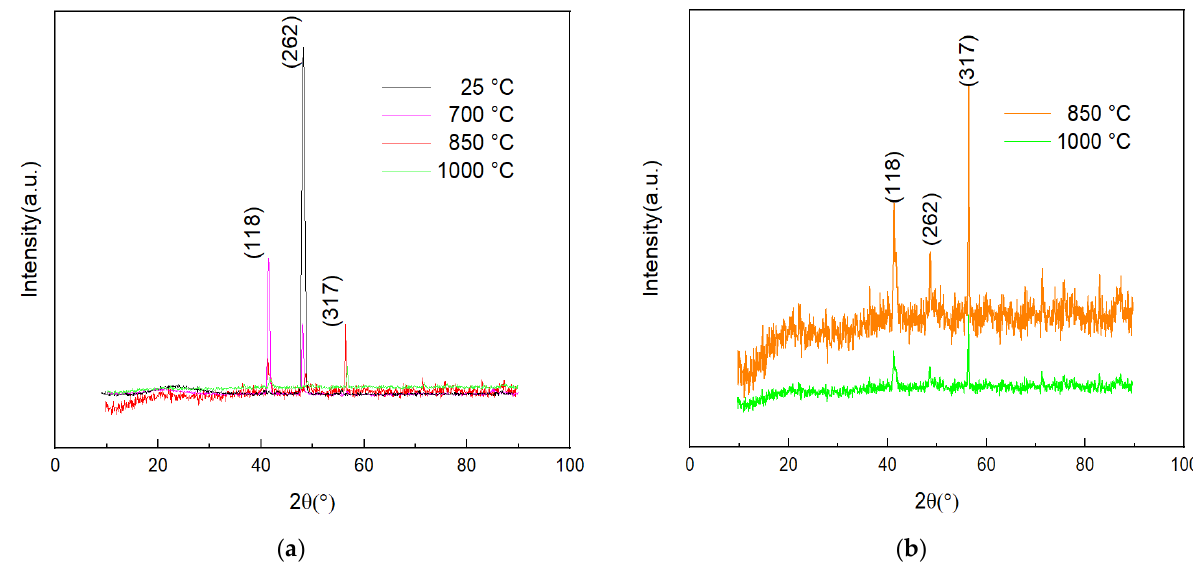
Figure 9. X-ray diffraction patterns for the Bi 3 La 1 Ti 3 O 12 coatings. ( a ) All study temperatures, ( b ) de- tails for temperatures of 850 °C and 1000 °C.